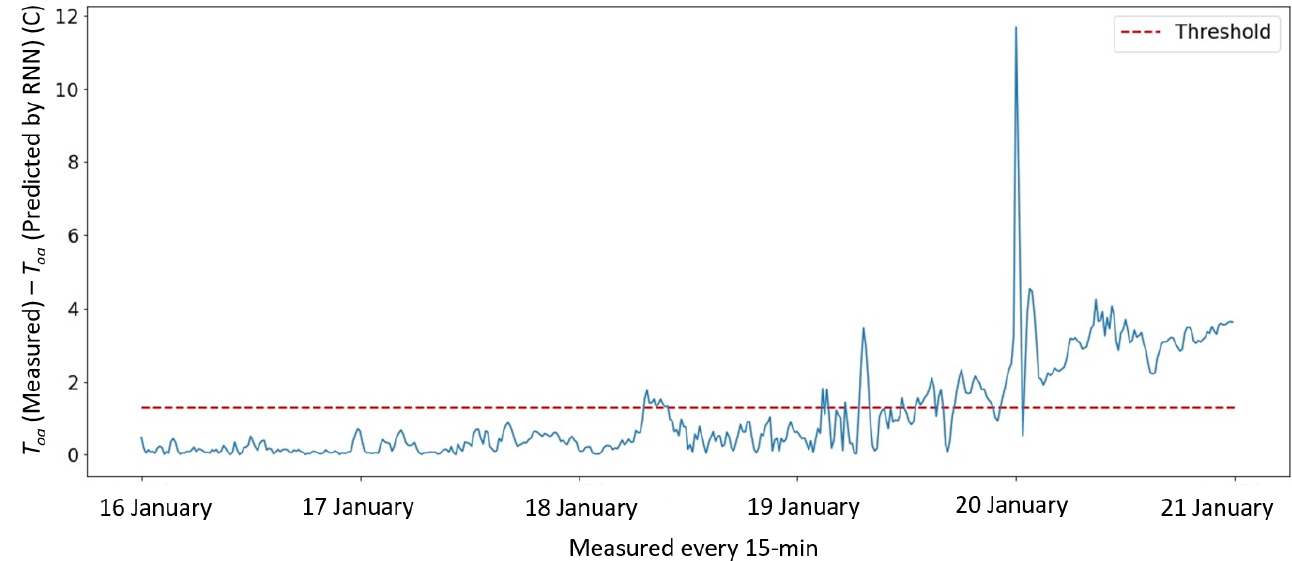
Figure 14 . Residual between measurements and predictions of T oa using RNN model .